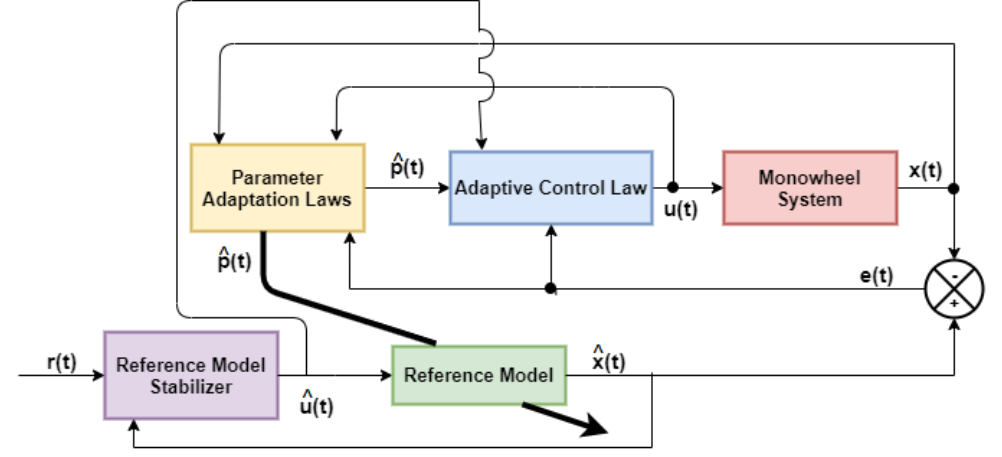
Figure 17. Model assisted adaptive control structure for Monowheel System.